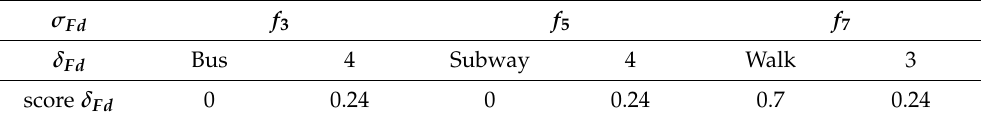
Table 7. Scores for the sub-sequence σ Fd .